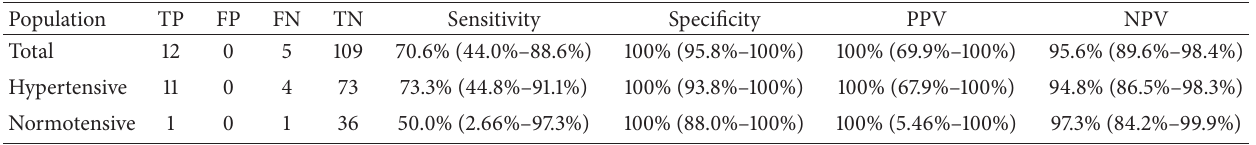
Table 1: Details of accuracy analysis in total, hypertensive, and normotensive